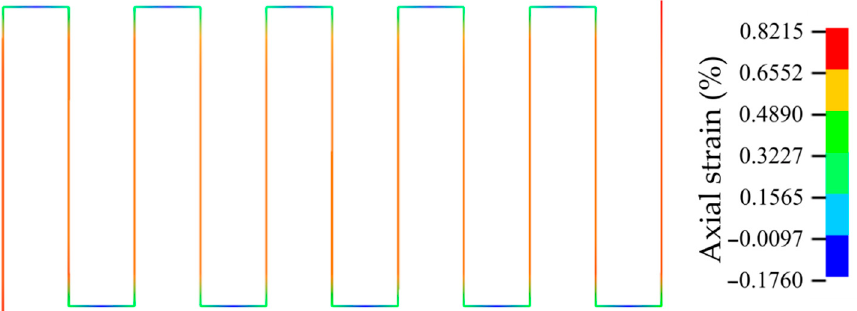
Figure 15. Visualization of strain in a loaded strain sensor (result of the FEA model).